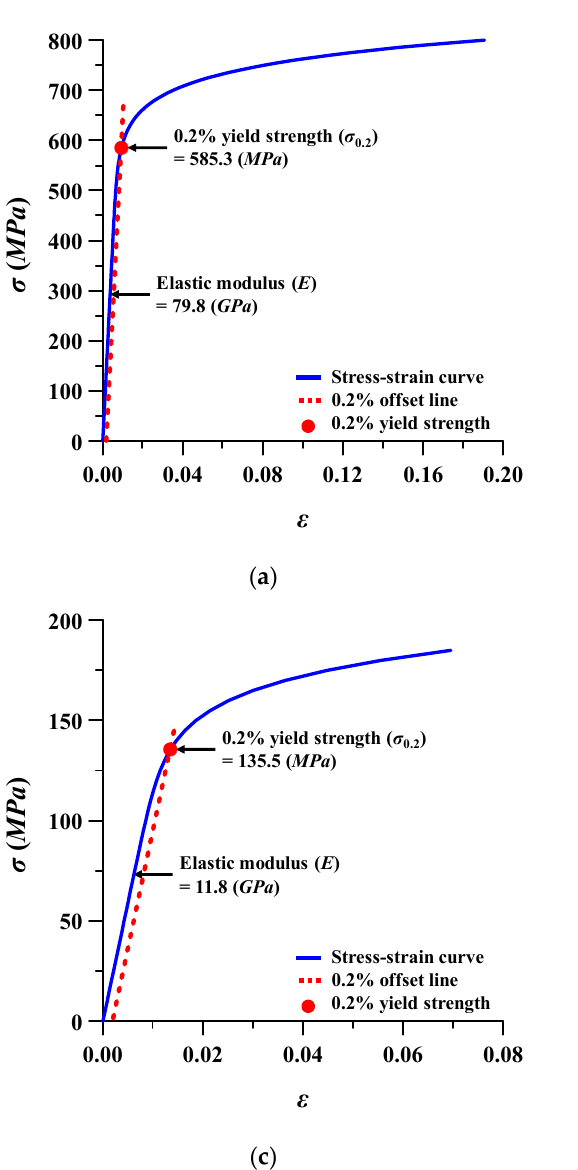
Figure 4. Estimation formula of material properties of Ti–6Al–4V at different porosities ( p ): ( a ) strain hardening exponent